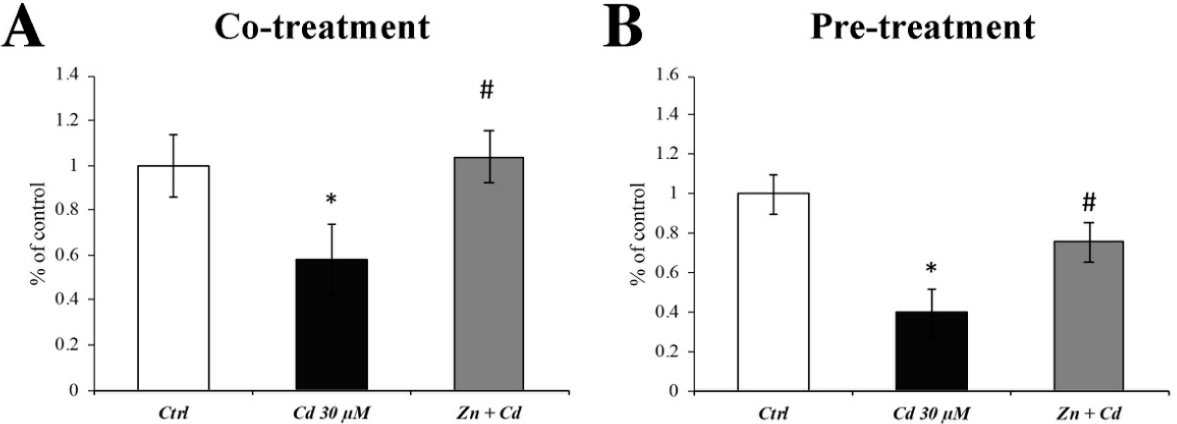
Figure 4. Efficacy of Zn in preventing Cd-induced decrease in SOD activity. Histograms show that CdCl 2 (30 µ M) significantly decreased SOD activity (black columns) compared with control (white columns) levels after 24 h of treatment. ZnCl 2 50 µ M significantly prevented the Cd-dependent downregulation of SOD protein activity, both during cotreatment (( A ); grey columns) and 24 h pretreatment (( B ); grey columns). Results are expressed as mean ± SEM and control (untreated cells) was arbitrarily taken as 100%. The total protein quantification was used as an internal control for protein normalisation. Each experiment point was performed in triplicate, from three different sets of experiments. * p < 0.05 vs. Ctrl; # p < 0.05 vs. Cd treatment.